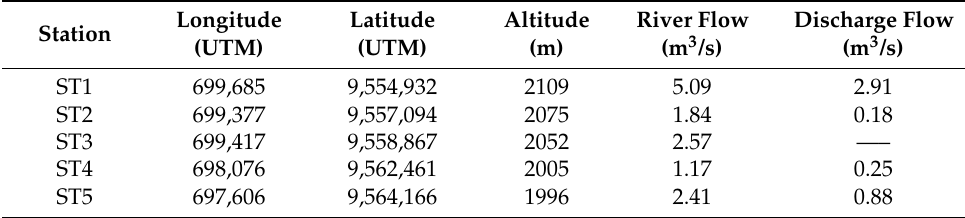
Table 1. Location of water sampling